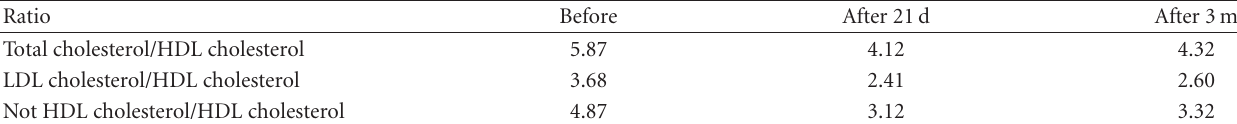
Table 6: Serum lipid ratios related with cardiovascular risk in adult type 2 diabetic adults with Ma-Pi 2 diet.